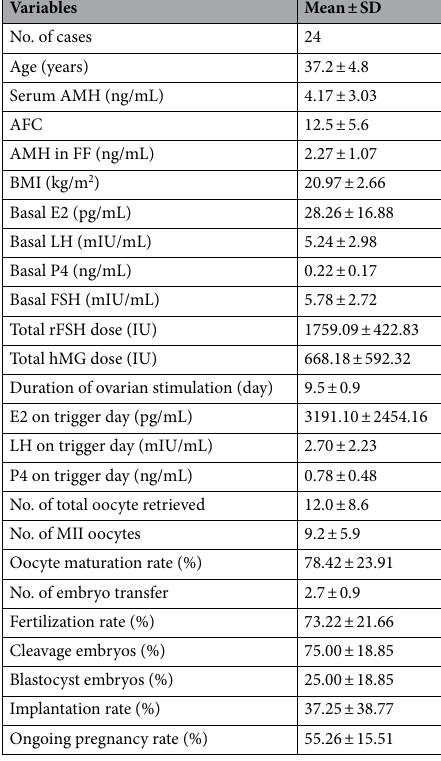
Table 1. The baseline parameters and IVF outcomes of the patients. AMH anti-Mullerian hormone, FF follicular fluid, BMI body mass index, MII metaphase II, AFC antral follicle count, E2 estradiol, LH luteinizing hormone, P4 progesterone, FSH follicle stimulating hormone, rFSH recombinant follicle stimulating hormone, hMG human menopausal